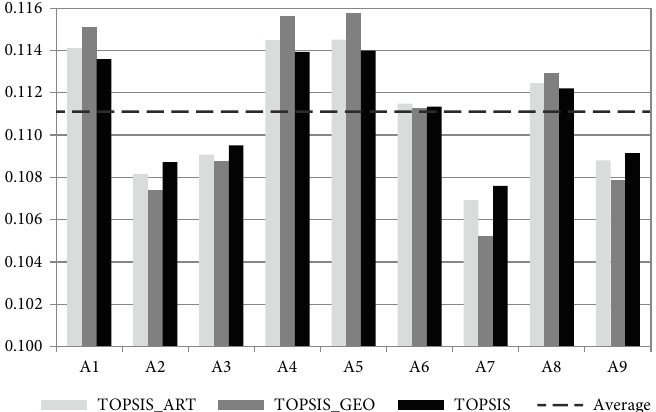
Figure 8. Comparison of the value of indicator J obtained by the TOPSIS for GDN with the same criteria weights for each gerontechnology type